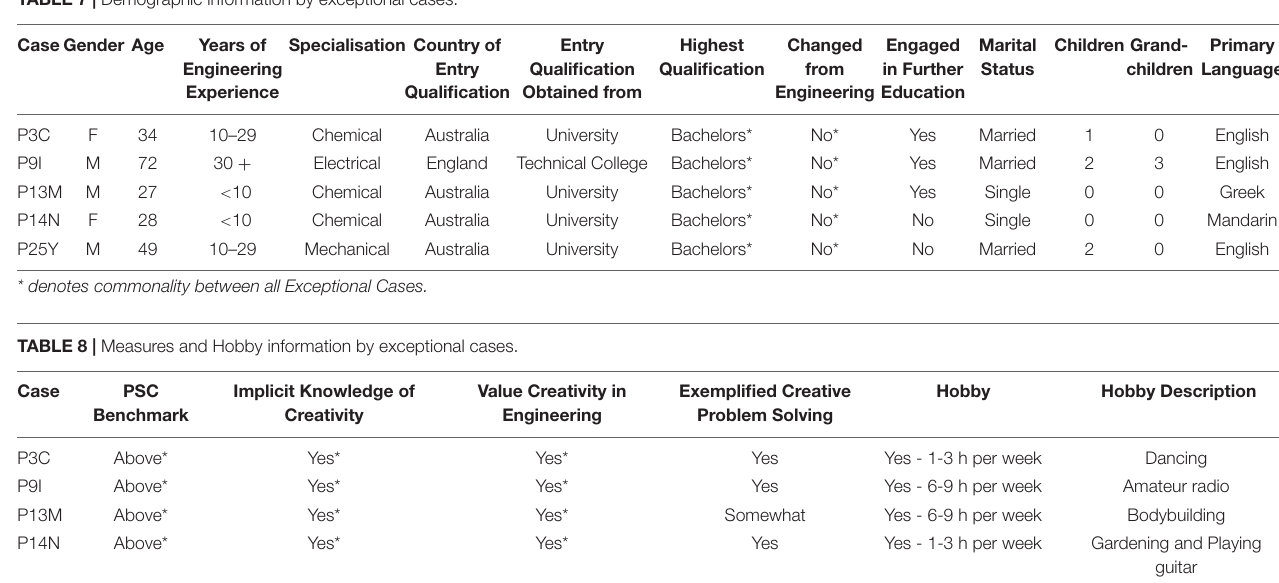
TABLE 7 | Demographic information by exceptional cases.